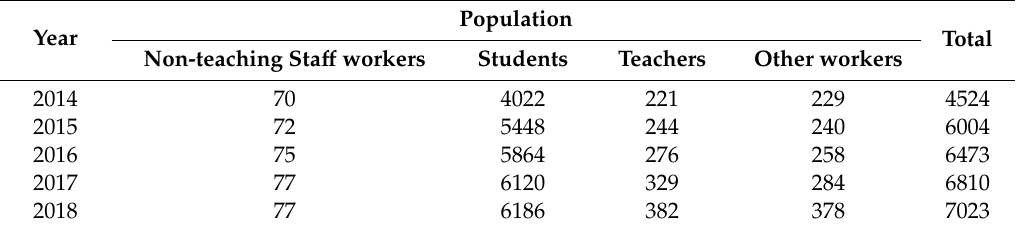
Table 4. Classification of population data (source: Registrar and human resource o ffi ce of Institute of Technology (IoT), Ambo University (AU)).